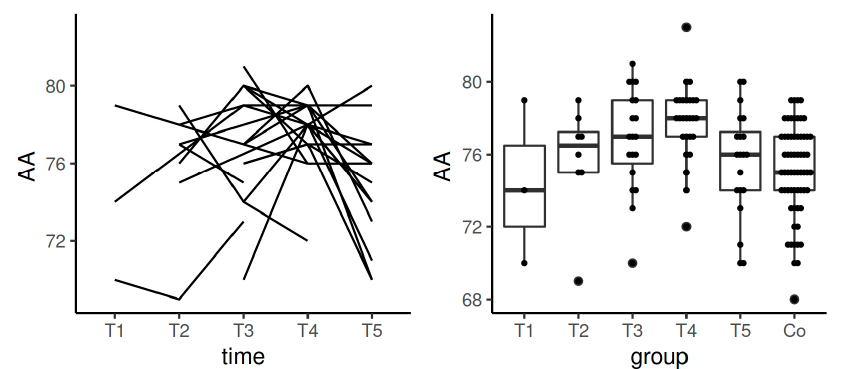
Figure 7. Spaghetti plot of the data from the longitudinal study (left), and swarmplot with boxplot of the same data together with the data from the control group (right)—the results of AA in INTEM. Legend: AA—alpha angle, Co—control group, T1—time interval 1, T2—time interval 2, T3—time interval 3, T4—time interval 4, T5—time interval 5.